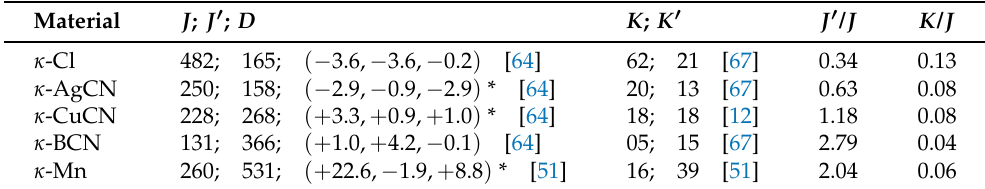
Table 1. Representative exchange parameters in K for indicated materials κ -(BEDT-TTF) 2 Cu[N(CN) 2 ]Cl ( κ -Cl), κ -(BEDT-TTF) 2 Ag 2 (CN) 3 ( κ -AgCN), κ -(BEDT-TTF) 2 B(CN) 4 ( κ -BCN), κ -(BETS) 2 Mn[N(CN) 2 ] 3 ( κ -Mn): Bilinear exchange J , J (cid:48) , D (defined in Equation (3) and Figure 4) and averaged four-spin ring exchange K , K (cid:48) (defined in Equation (5) and Figure 4). The DM vectors for the Pnma salts are given in the coordinate system ( a , b , c ) , while the P 21/ c values are indicated with () * and given with respect to ( a , b , c *). The ratio J (cid:48) / J indicates the deviation from the isotropic triangular limit J (cid:48) / J = 1 and K / J indicates the significance of the four-spin ring exchange. This table is not intended to be a complete representation of available results, but serves as orientation with selected